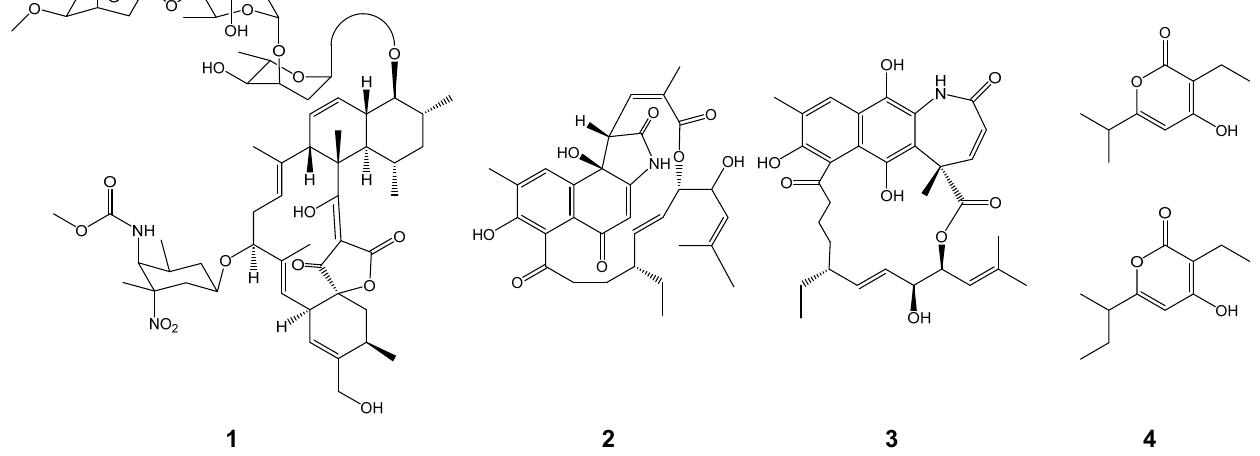
Figure 1. Chemical structures of lobophorin C ( 1 ), divergolides C ( 2 ) and D ( 3 ) and germicidins ( 4 ).